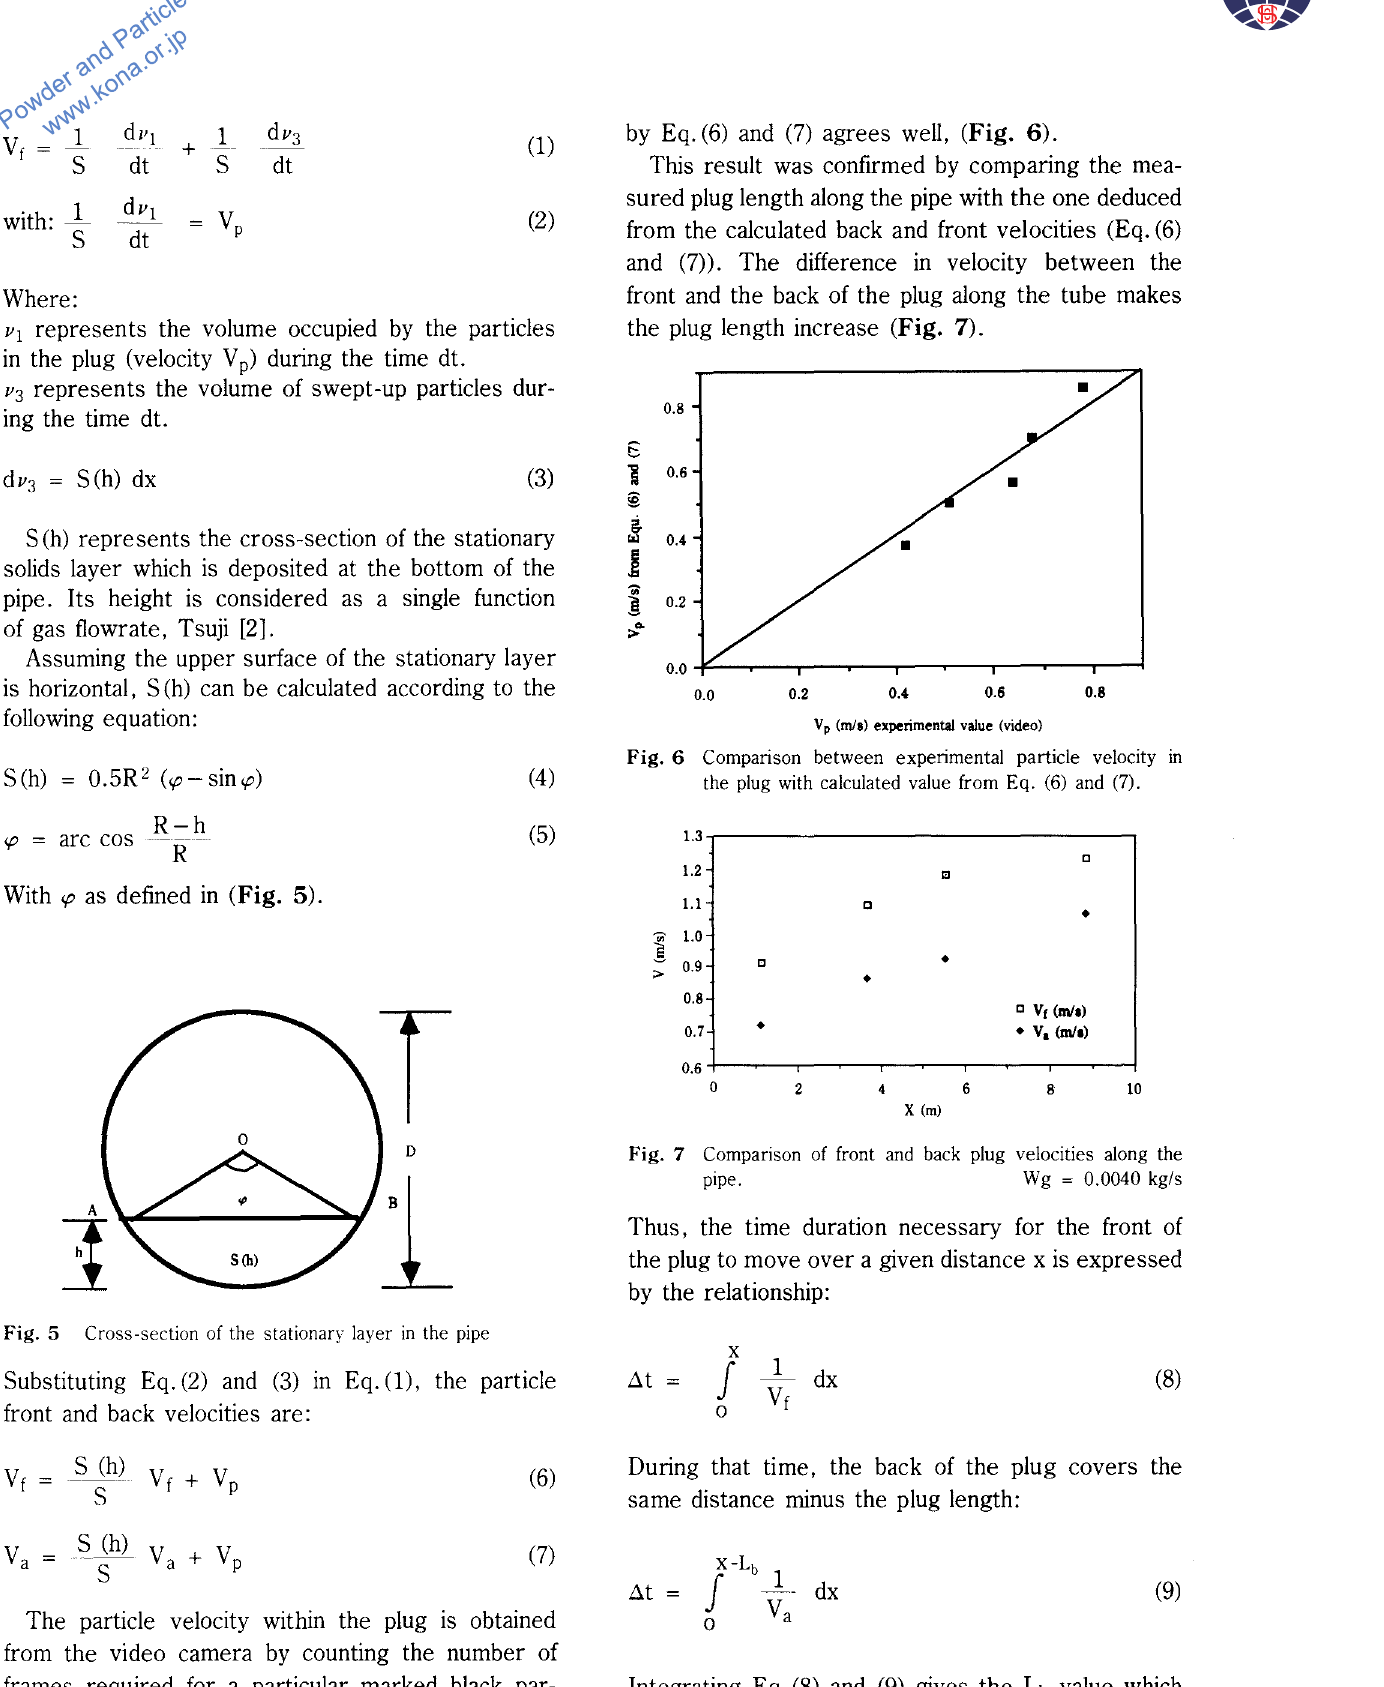
Fig. 7 Comparison of front and back plug velocities along the pipe. Wg = 0.0040